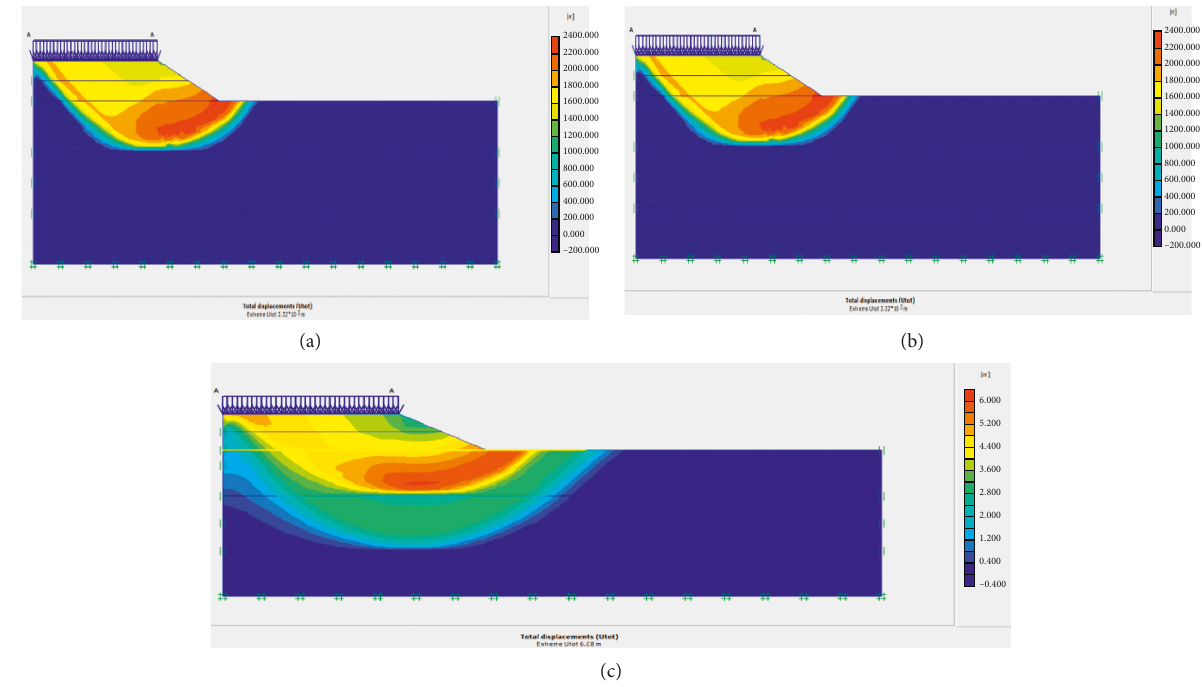
Figure 9: Total displacements of H2S2. (a) Natural soil (b) unreinforced stabilized soil. (c) Geogrid reinforced stabilized soil.